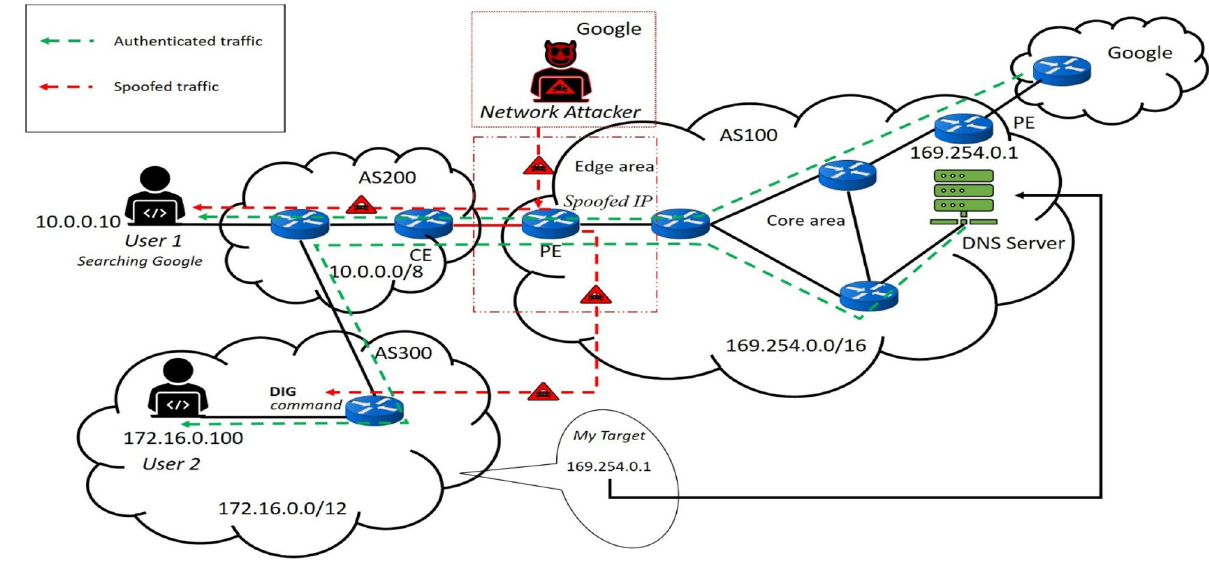
Figure 3. Example of PE router security